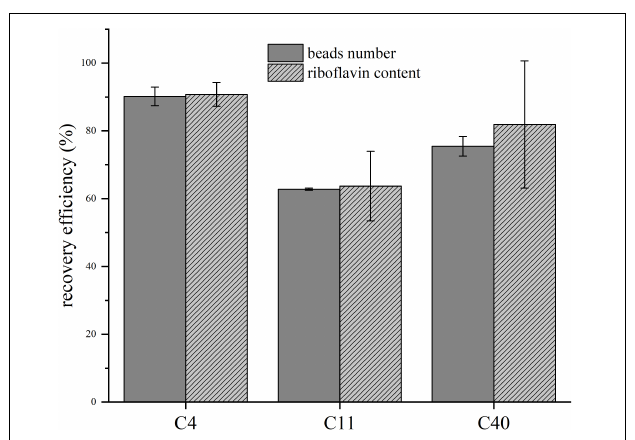
FIGURE 3 | Recovery efficiencies of the beads and riboflavin content before and after batch experiments. C4/C11/C40 represent riboflavin-coupled beads with the respective chain lengths. Gray bars show the normalization to the beads number, striped bars to riboflavin content before the experiment and after the recovery process. Error bars represent the standard deviations from means of samples taken in independent triplicates.